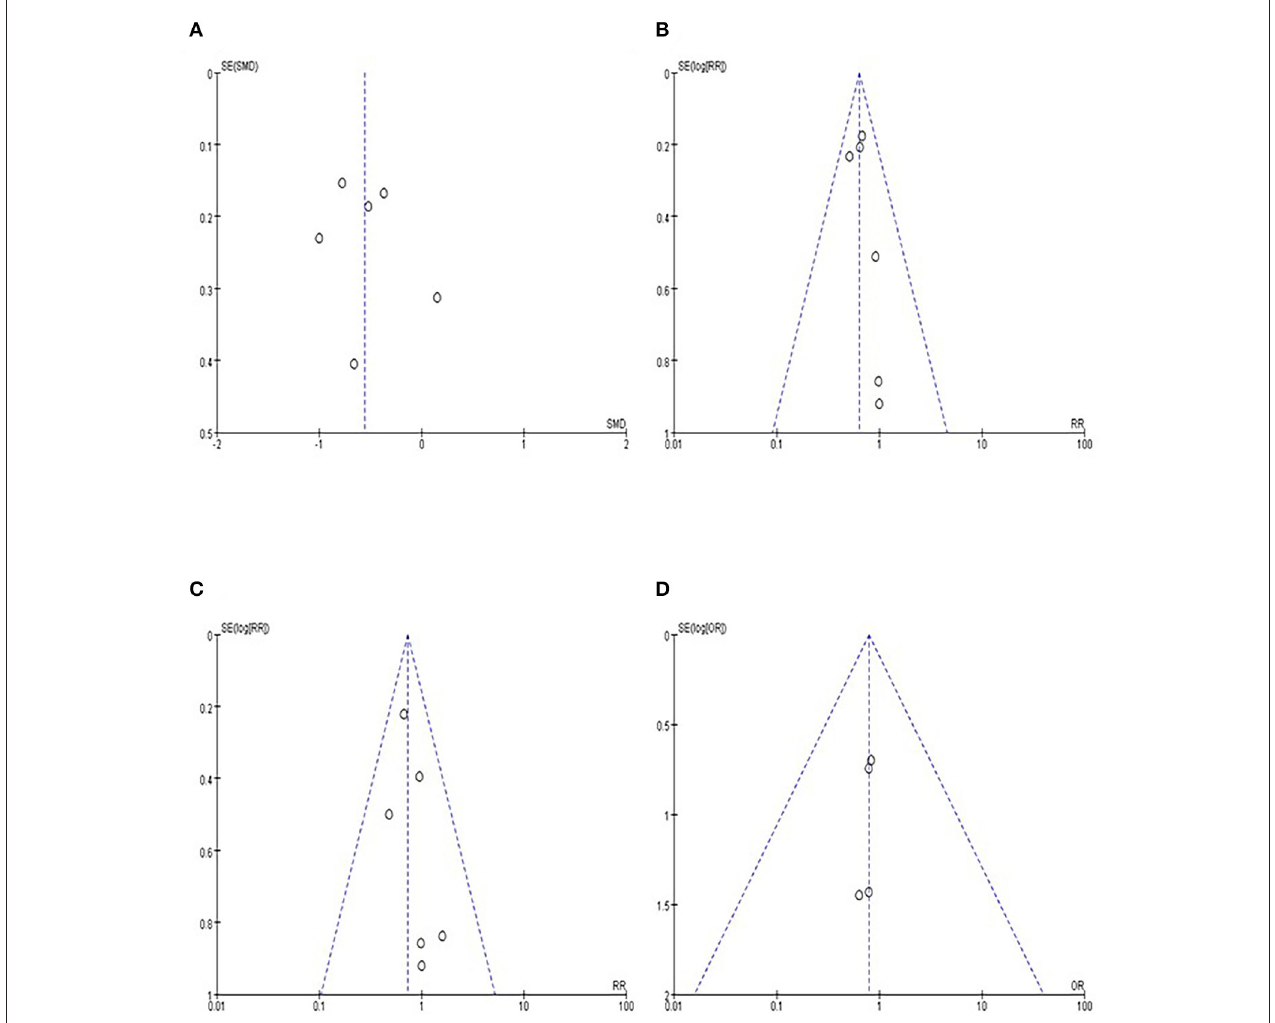
FIGURE 5 | Funnel plot of (A) LOS, (B) overall postoperative complication rate, (C) grade I complication rate, and (D) readmission